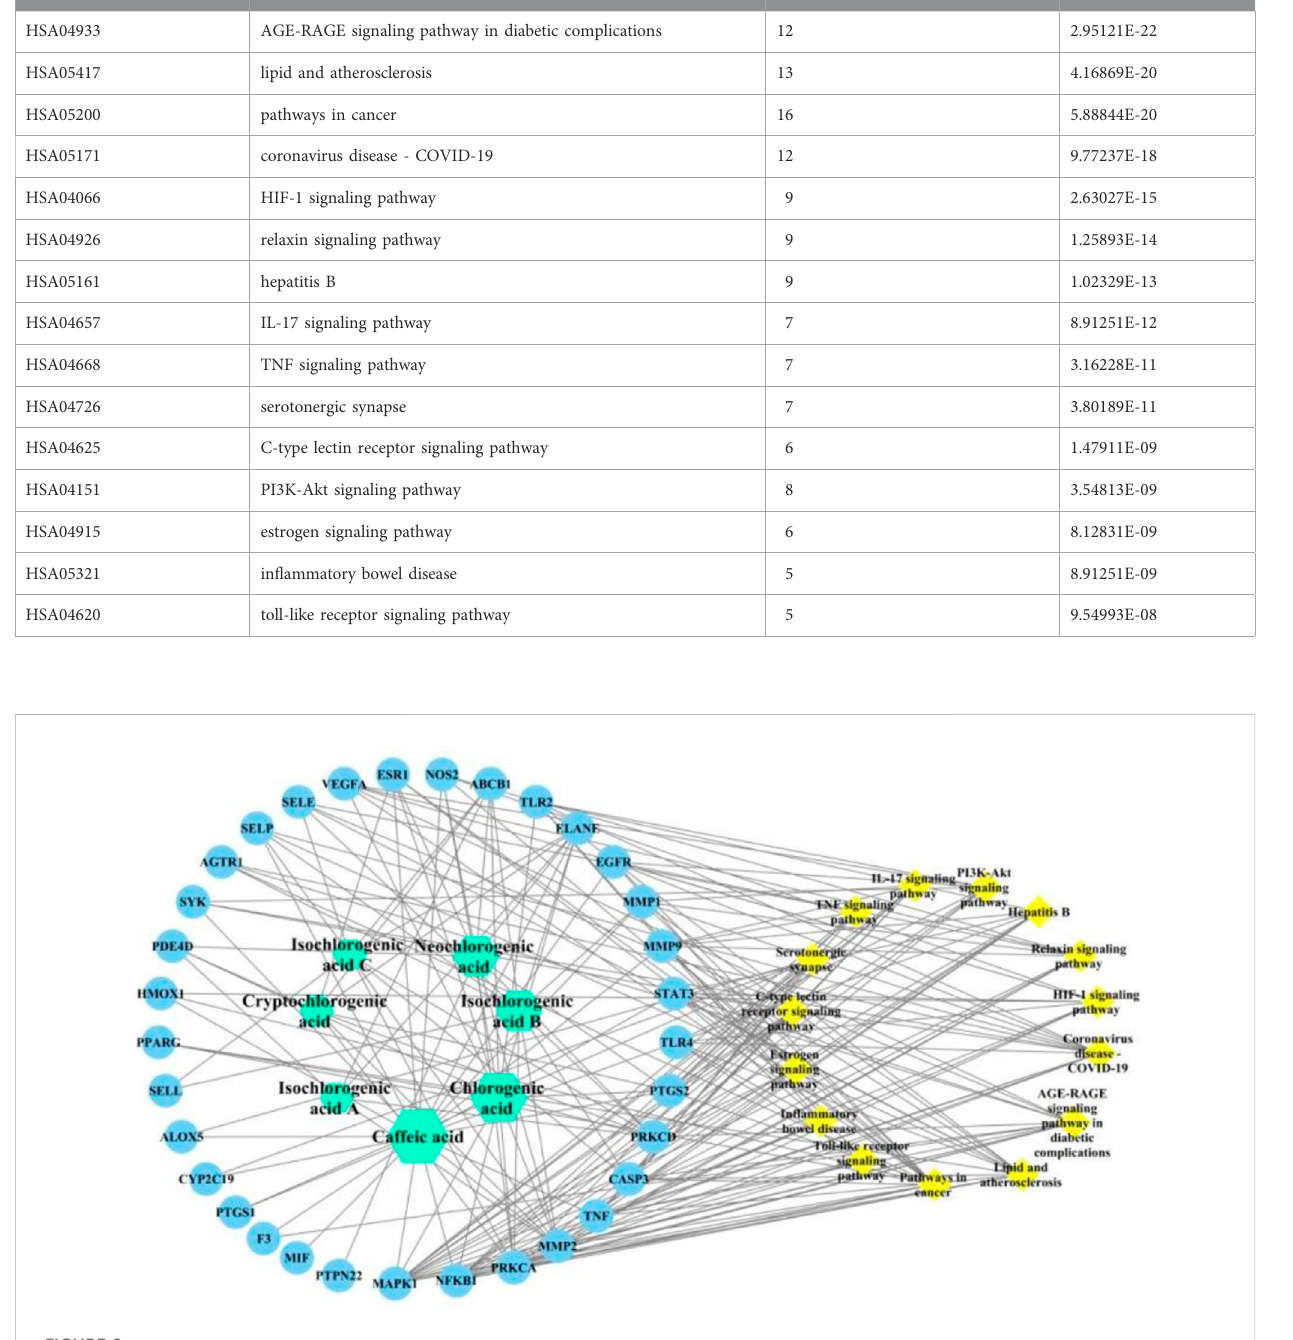
FIGURE 9 Target-pathway network of the 7 phenolic acids in treating